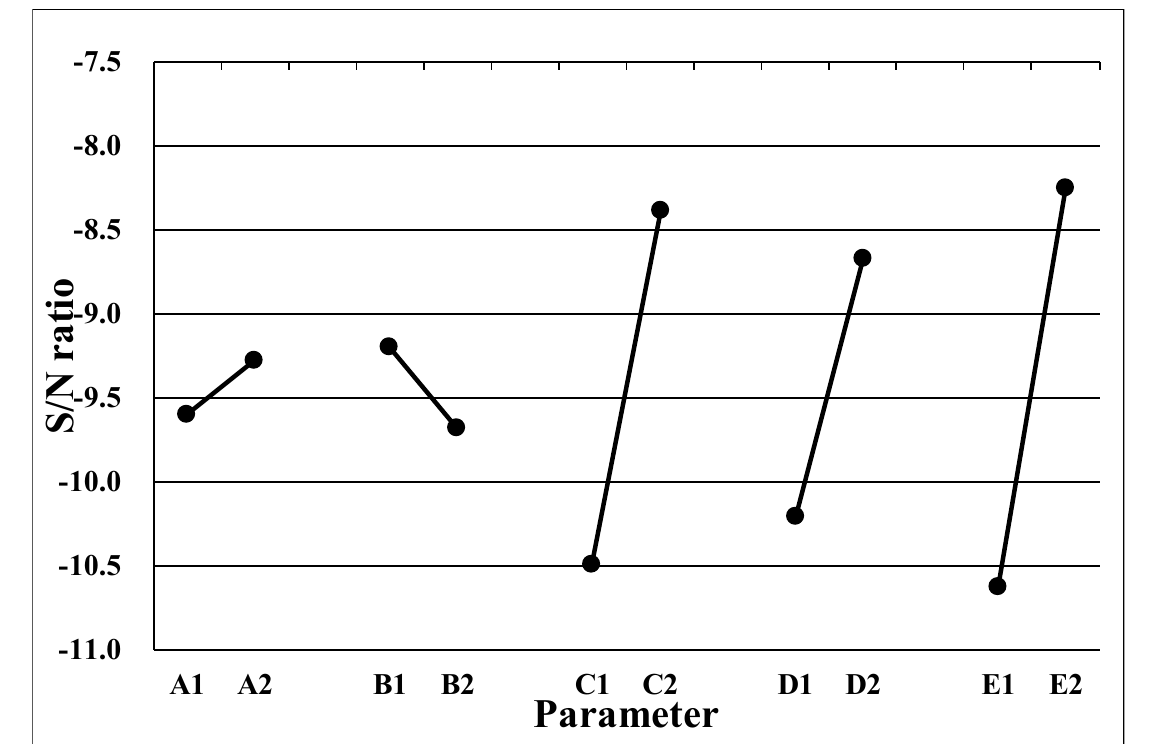
Figure 6. The S/N reaction diagram of uniformity of light guide plate with microstructure.